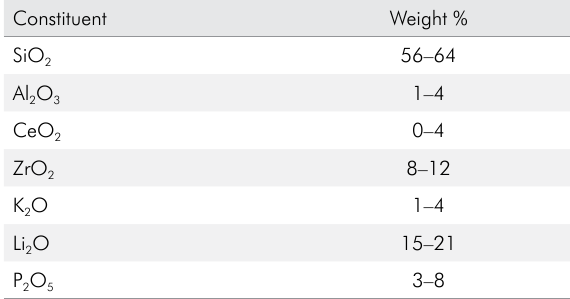
Table 3. Composition of lithium silicate-based glass-ceramics.